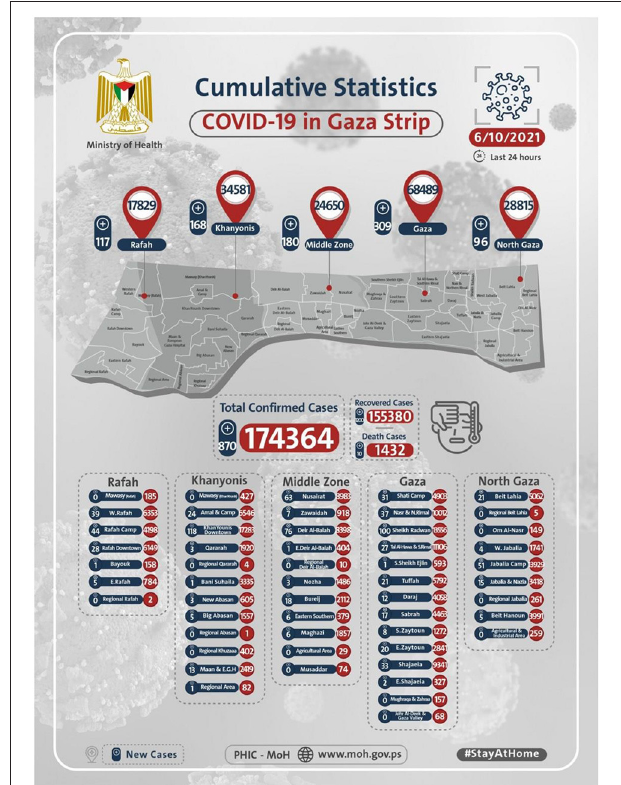
Figure 1 | The total number of COVID-19 cases in the Gaza Strip, including the cases’ distribution on its five governorates. Source: http://www.moh.gov.ps/portal/ ﺮﻳﺮﻘﺘﻟﺍ - ﻲﻣﻮﻴﻟﺍ - ﺱﻭﺮﻴﻔﻟ - ﺪﻴﻓﻮﻛ -19- ﺰﻛﺮﻣ - ﻢﻟﺍ /.